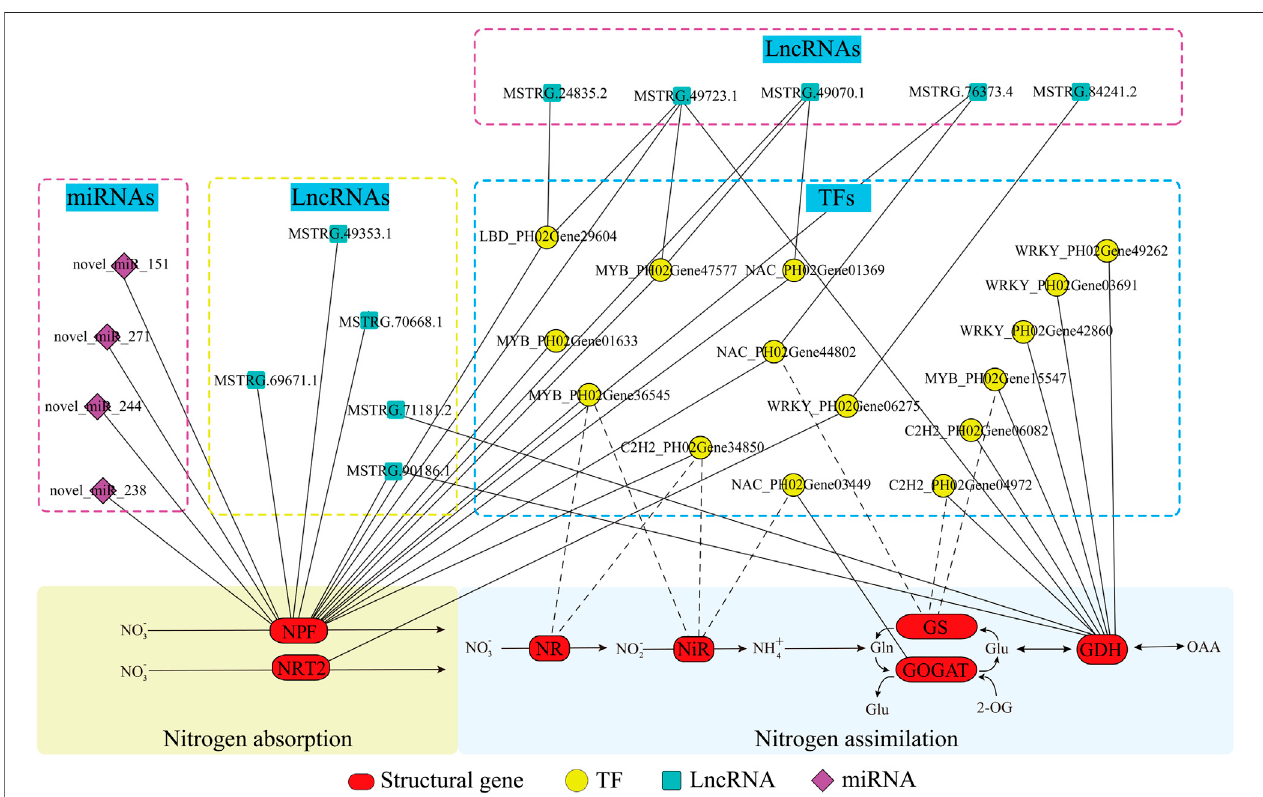
FIGURE7| Predictedregulatorynetworkofnitrogenmetabolisminmosobamboo.Structuralgenes,TFs,miRNAs,andlncRNAsaremarkedwithredovals,yellow circles, blue blocks, and purple rhombuses, respectively. The solid lines and dotted lines indicate the potential regulated relationship between the two elements supported by experiments and only prediction,